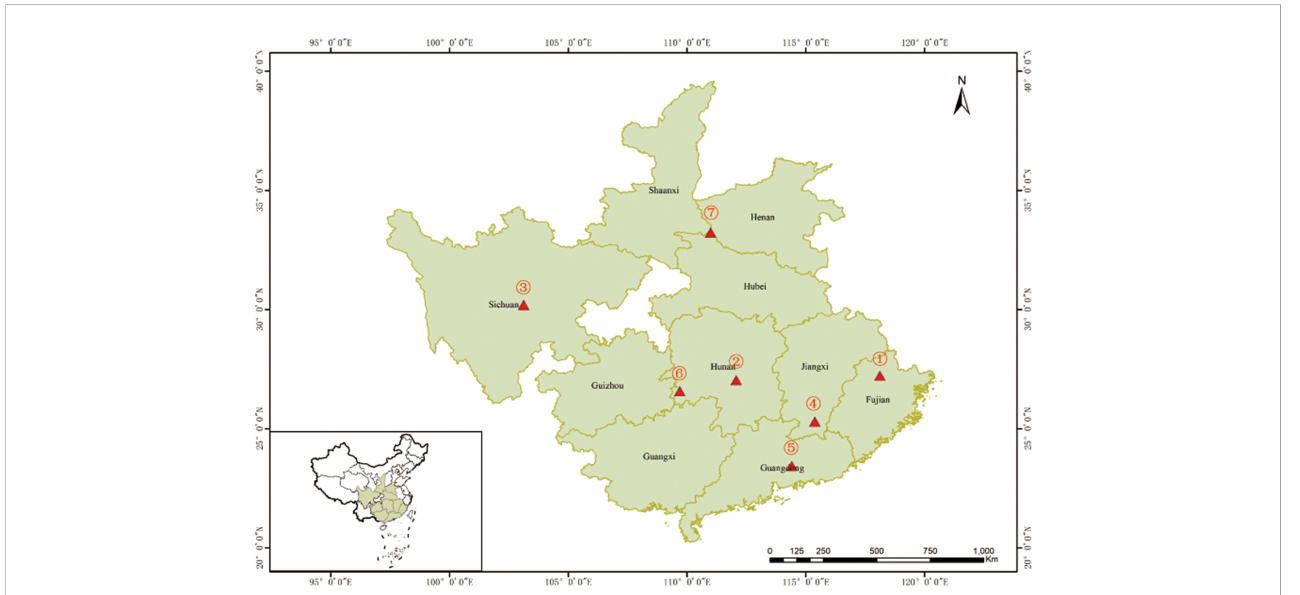
FIGURE 1 Origin of the 233 Chinese fi r germplasm. ① ~ ⑦ represent the seven Chinese fi r provenances (Fujian, Hunan, Sichuan, Jiangxi, Guangdong, the boundary of Hunan, Guizhou and Guangxi, and the boundary of Shaanxi, Henan and Hubei). The mixed sources are not shown in the fi